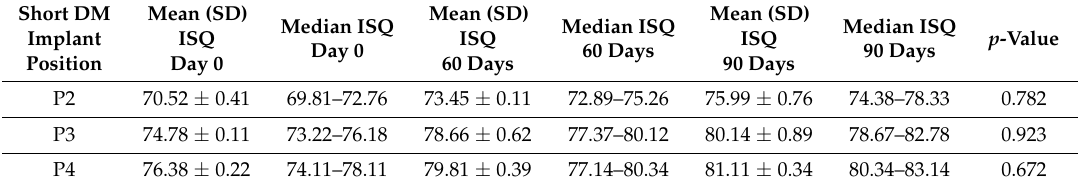
Table 3. ISQ mean values at 0 days, 60 days, and 90 days of the extra-short narrow ring implants.